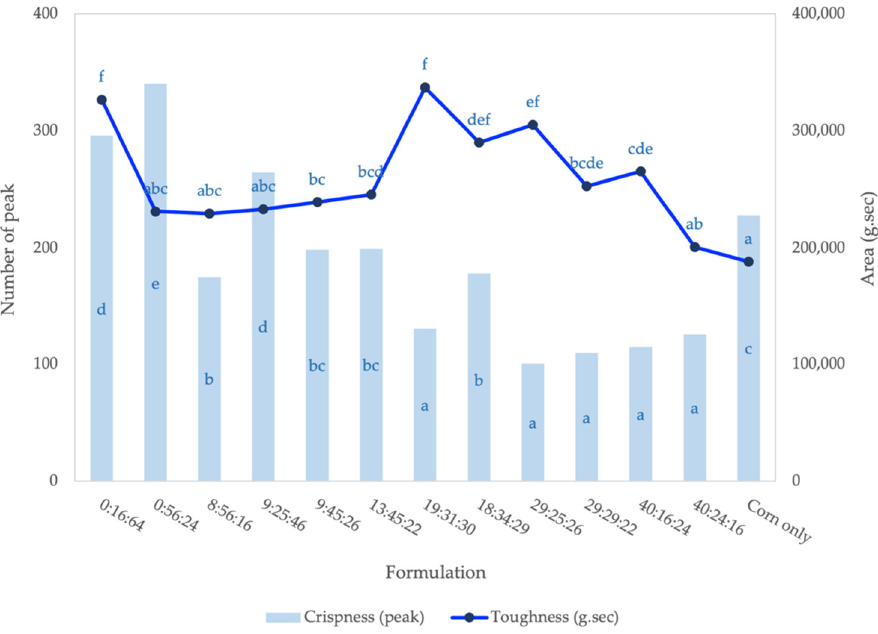
Figure 8. Crispness (primary axis) and toughness (secondary axis) of extruded snacks with different proportion of flours (%okara: %mung bean: %rice). a–f Means with different letters within the same response are different ( p < 0.05; n = 3).